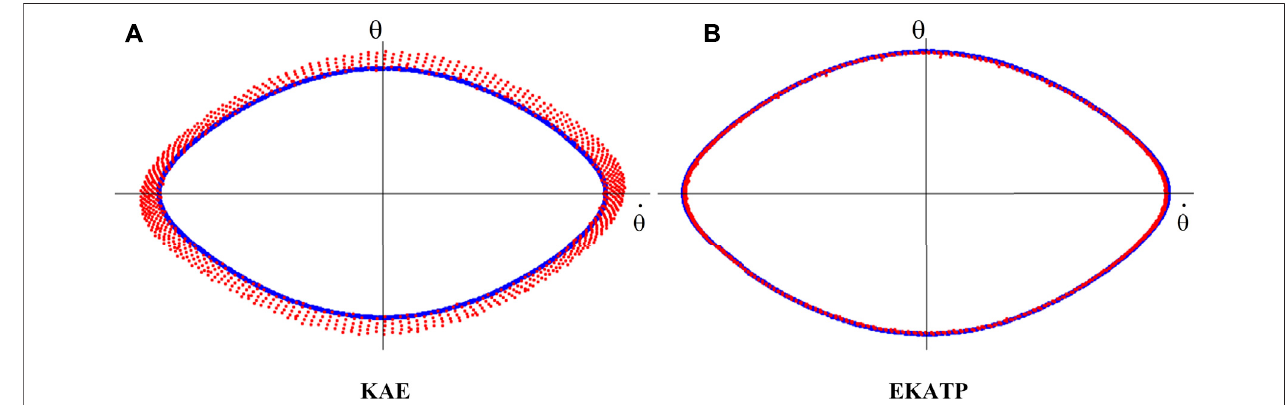
FIGURE 5 | The prediction trajectories within 1,000 steps under the initial conditions of h (cid:1) 2.4 and σ (cid:1) 0.03. The abscissa represents _ θ , the ordinate represents θ , blue colours represent true data and red dots represent predictive data. (A) KAE. (B) EKATP.